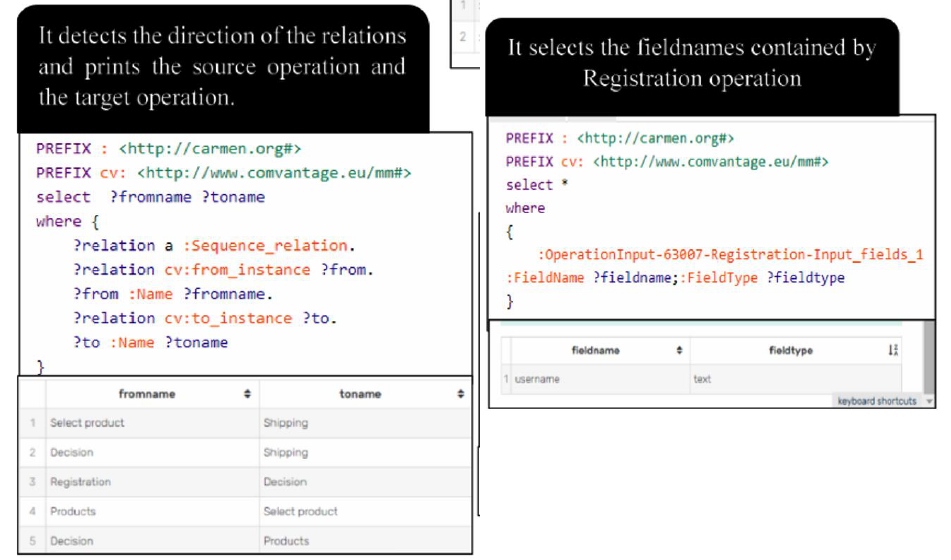
Figure 8. Semantic query examples for retrieving model